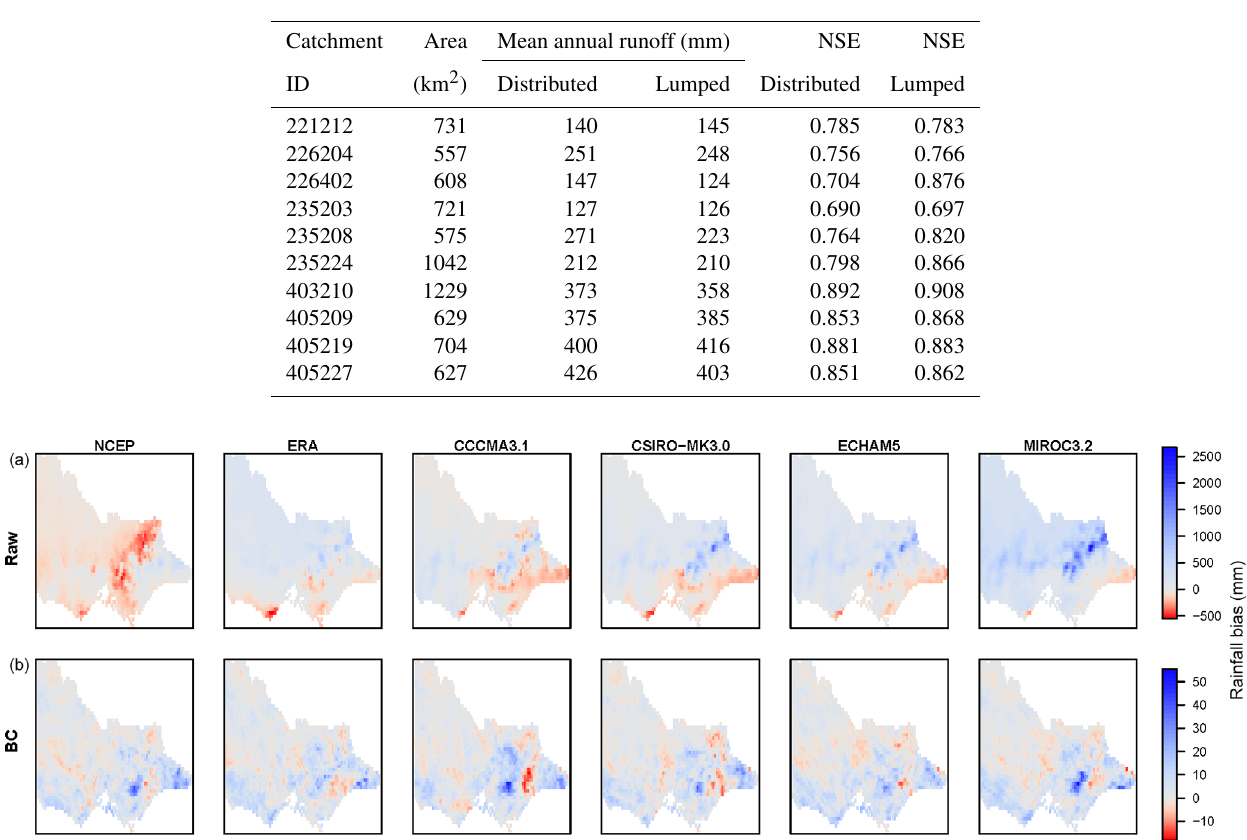
Table 1. Catchment attributes and distributed and lumped calibration (1990–2009 period) runoff and NSE metrics.